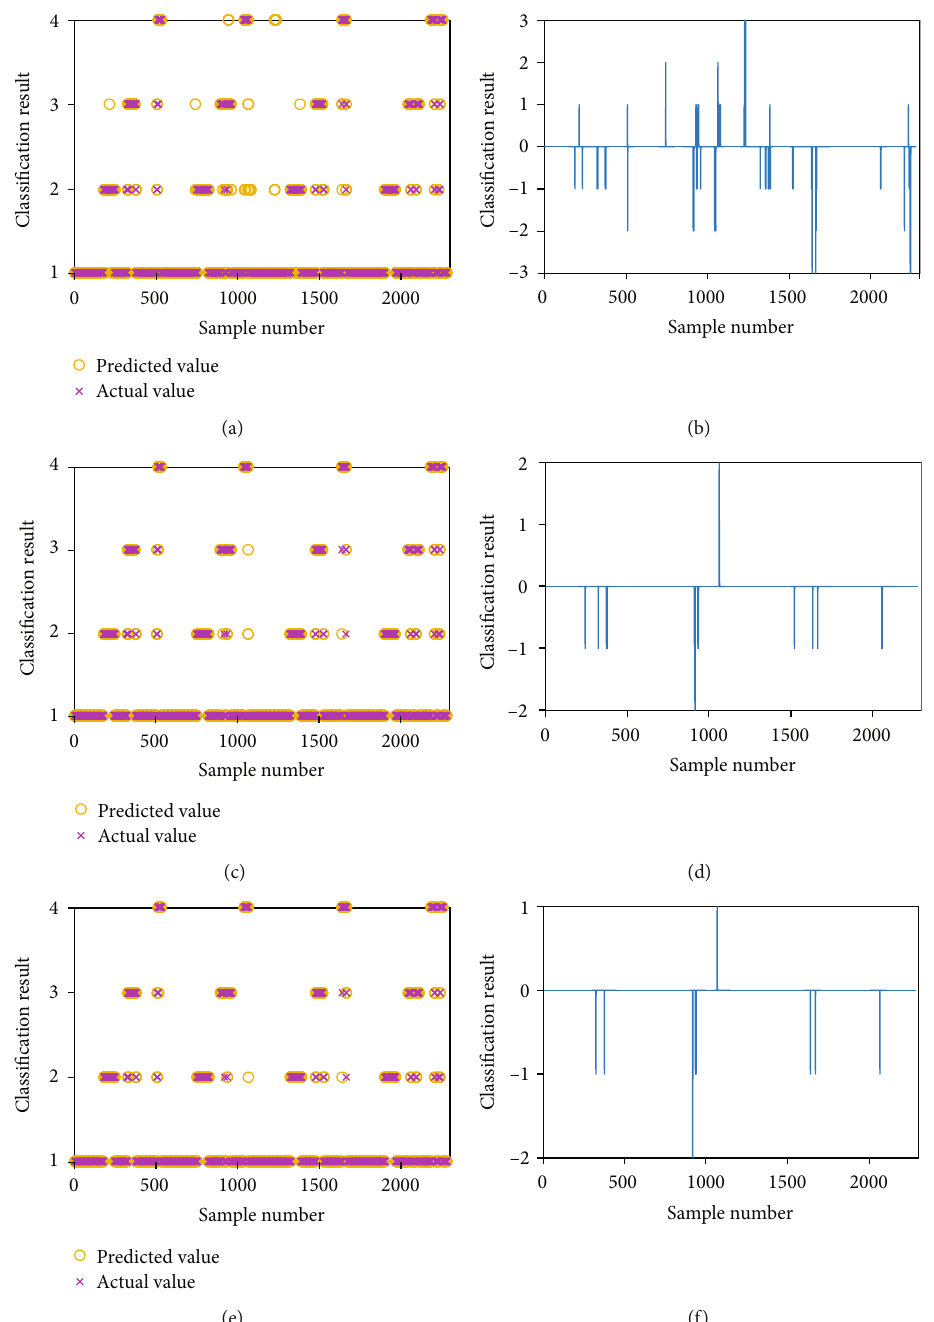
Figure 9: Training result comparison of di ff erent algorithms. (a) ANN training result. (b) ANN training error. (c) PNN training result. (d) PNN training error. (e) GRNN training result. (f) GRNN training